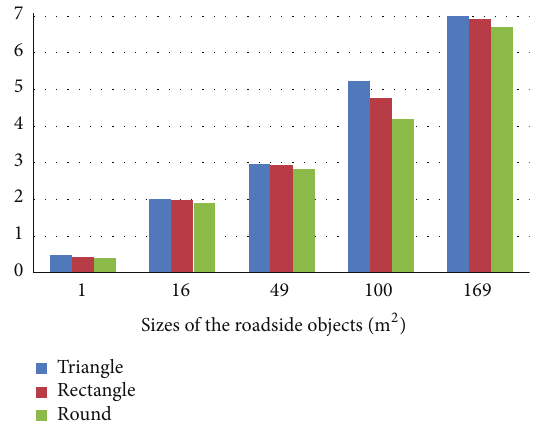
Figure 8: The legibility assessment of the objects under 120km/h.